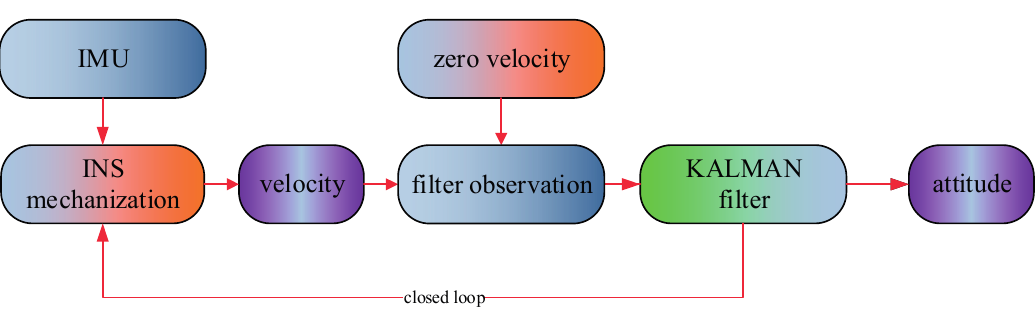
Figure 1. The fine